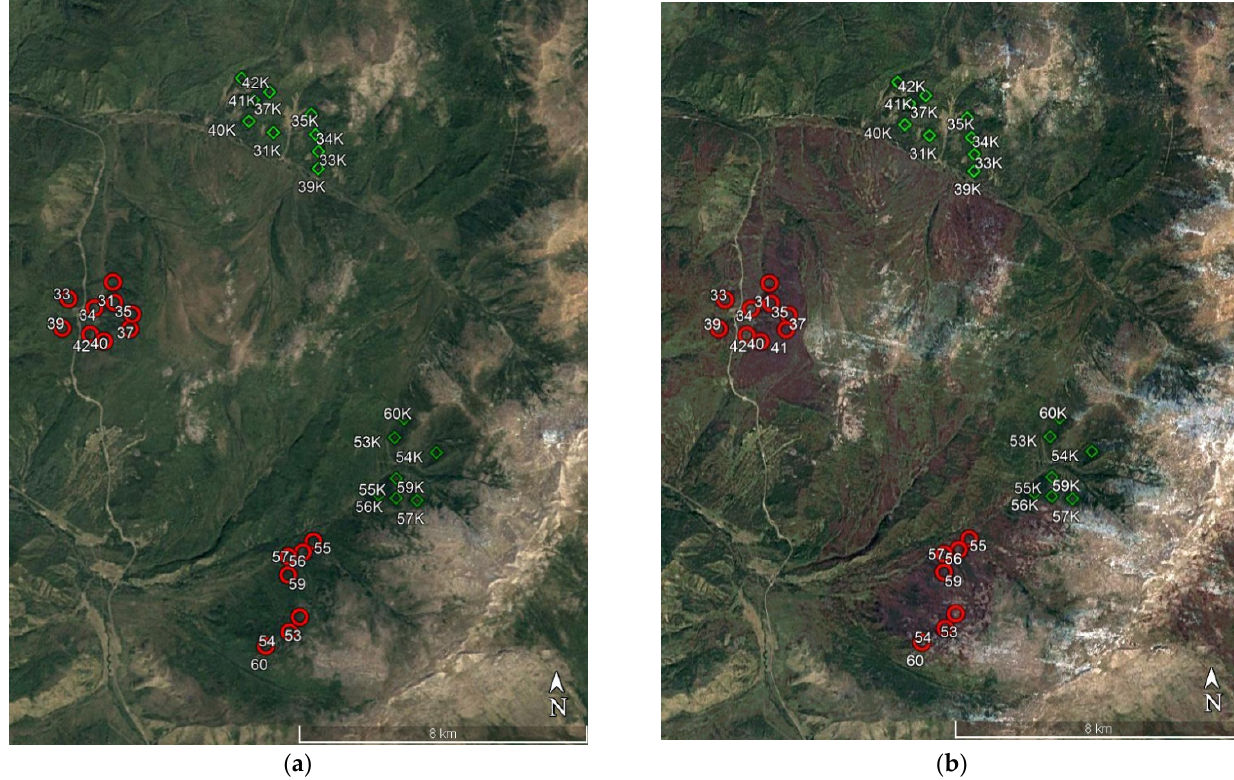
Figure 4. Test plots in the outbreak of black fir sawyer (southern area of the Ermakovsky district, Krasnoyarsk region, Russia) before (( a ), 2011) and after (( b ), 2013) the outbreak. Red dots—stands damaged by the pest; green dots—undamaged stands.